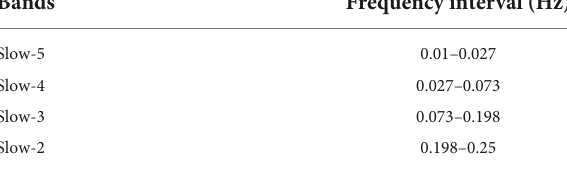
TABLE 2 Frequency range for the four canonical